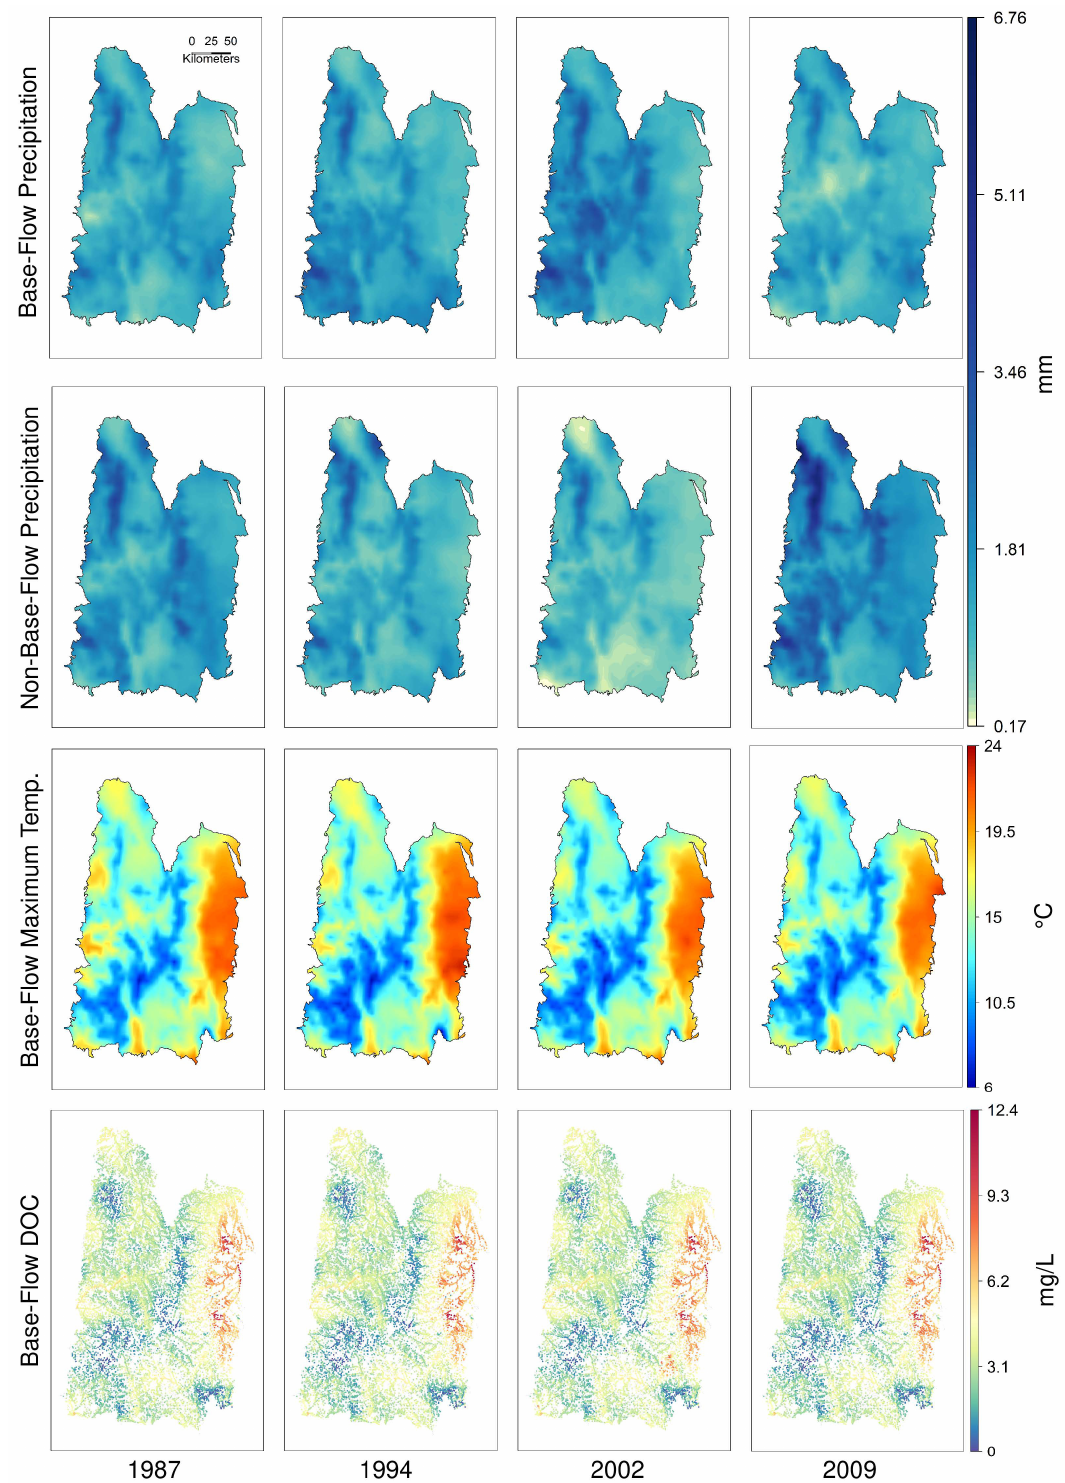
Figure A11. Comparison of significant climatological predictors (mean base-flow monthly precipitation, mean non-base-flow monthly precipitation, and mean base-flow monthly maximum temperature) and predicted base-flow DOC concentrations in the region of interest for the years 1987, 1994, 2002, and